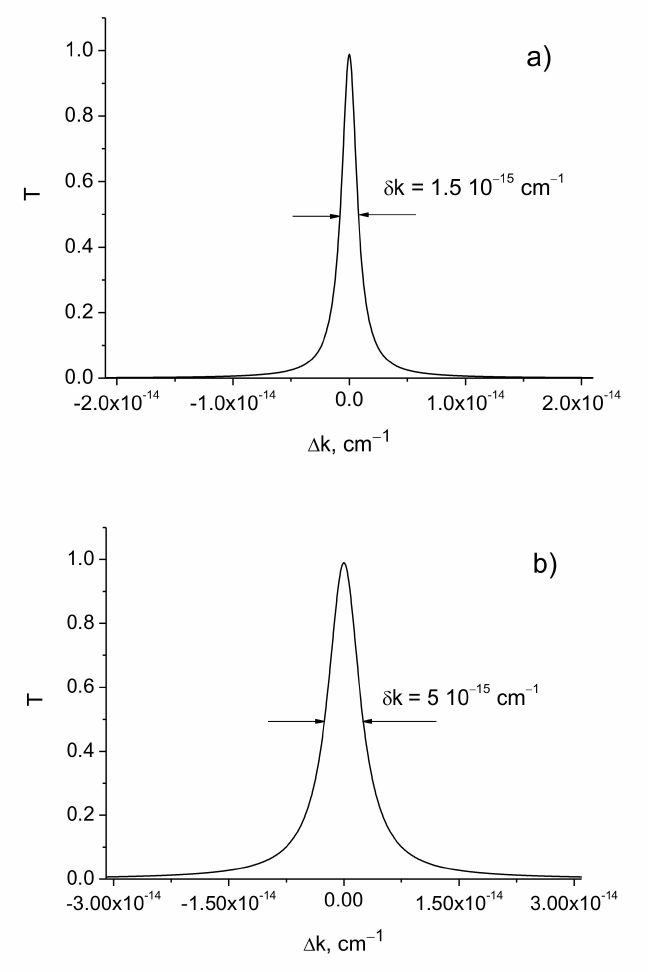
Figure 6. Transmission curves for different values of absorption. ( a ) n i = 1.2 · 10 − 8 ; ( b ) n i = 10 − 6 .